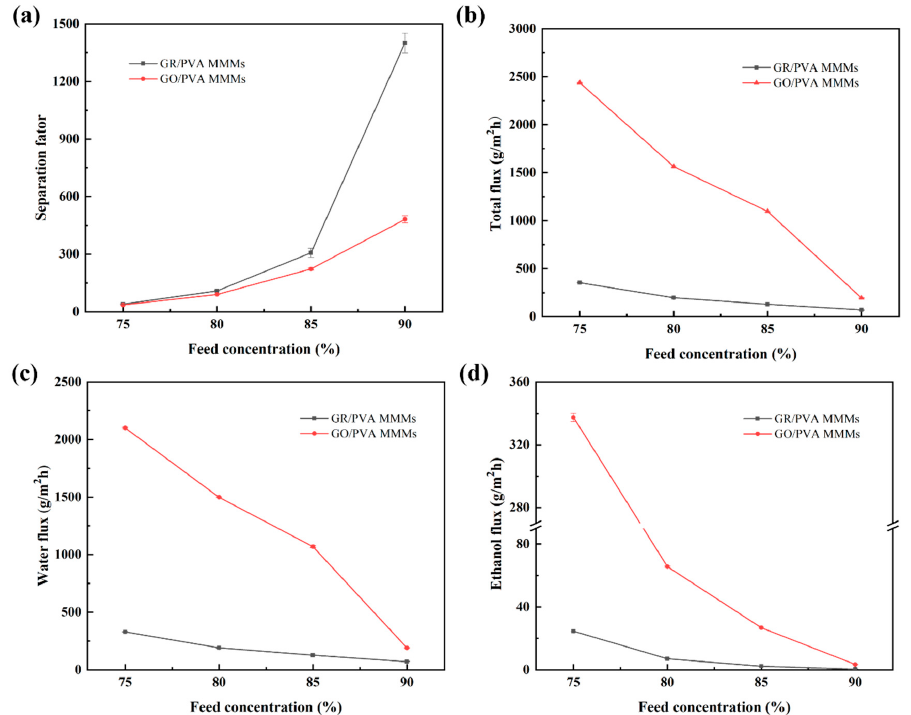
Figure 11. Effect of ethanol concentration on PV performance of GR/PVA and GO/PVA MMMs: ( a ) Separation factor; ( b ) Total flux; ( c ) Water partial flux; ( d ) Ethanol partial flux.